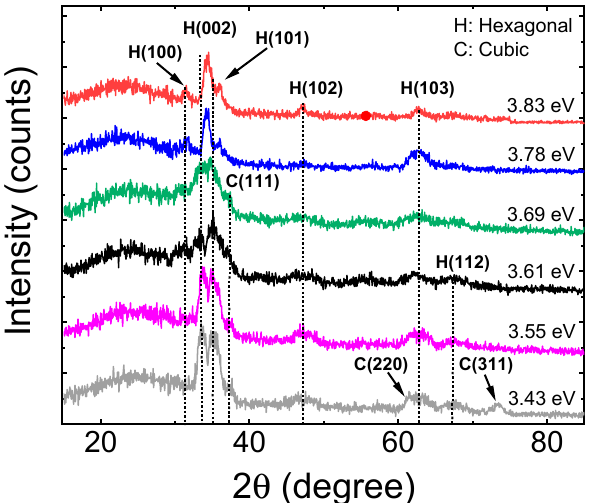
Figure 1. X-ray diffraction patterns measured with Cu-K α radiation (wavelength: 0.154056 nm) for Mg x Zn 1 − x O thin films deposited with different Mg contents on room temperature soda lime glass substrates and annealed at 250 °C for 120 min. The samples are labelled according to their bandgaps.